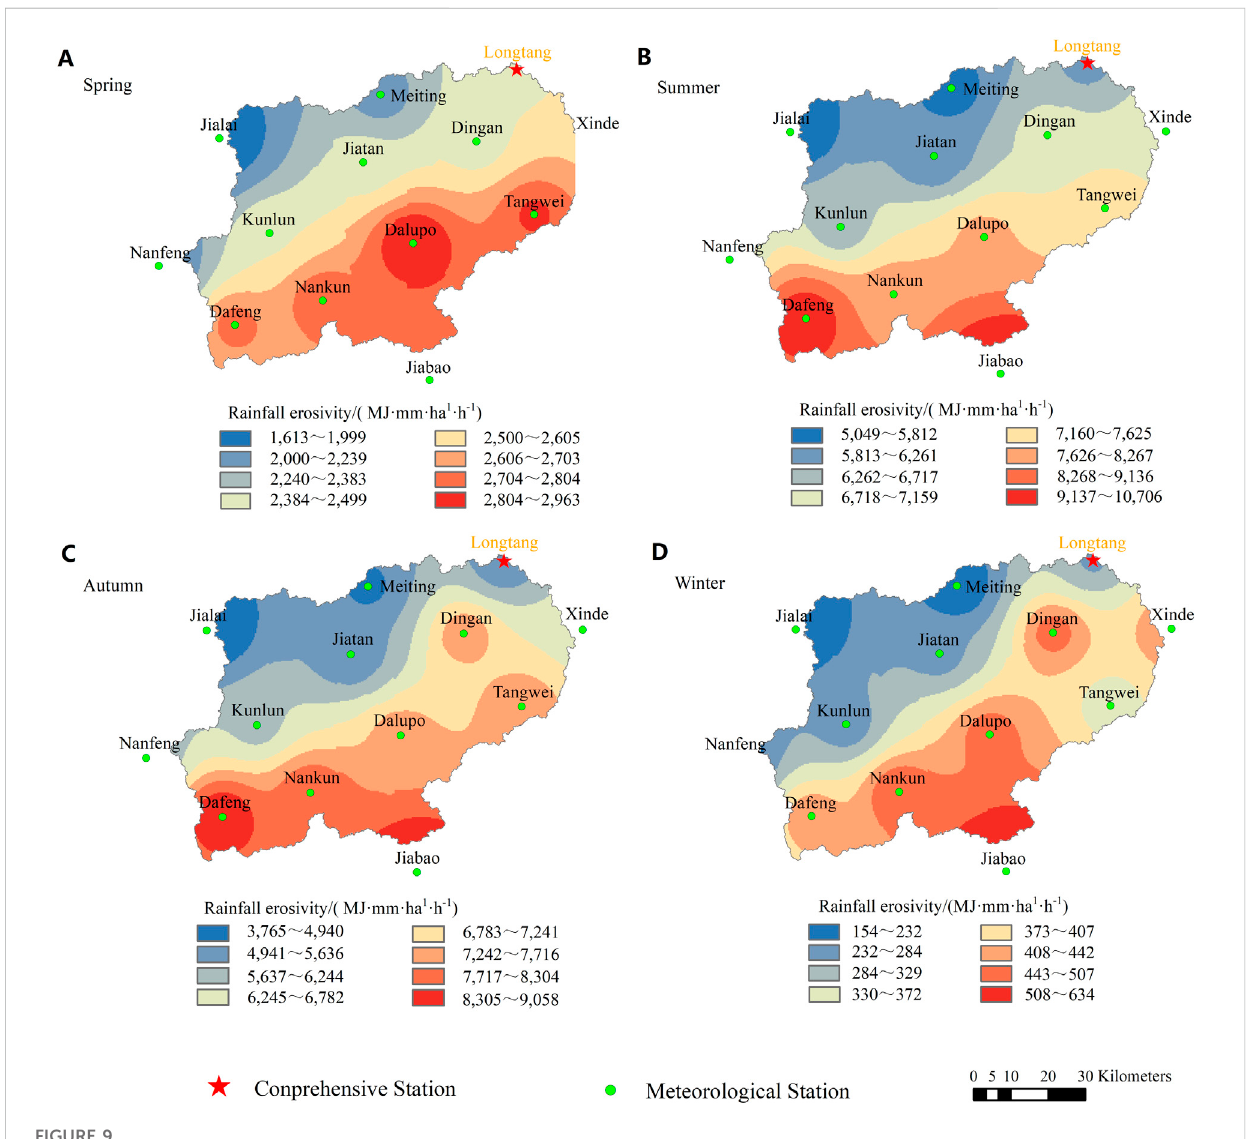
Spatial distribution of seasonal rainfall erosivity in the Nandu River